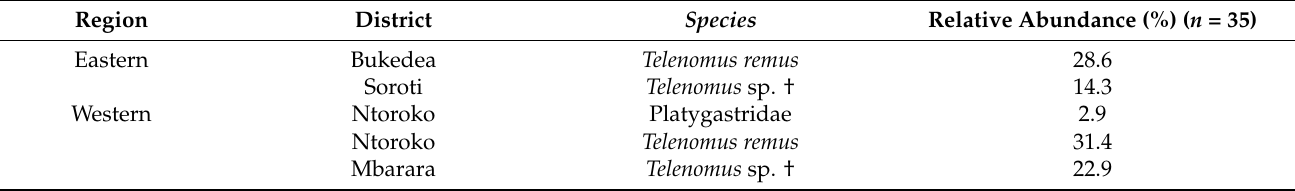
Table 2. Occurrence and relative abundance of egg parasitoids recovered from Spodoptera frugiperda in different districts of Uganda in 2019. † Nucleotide identity to Telenomus remus (MK533751) at 96.6%.